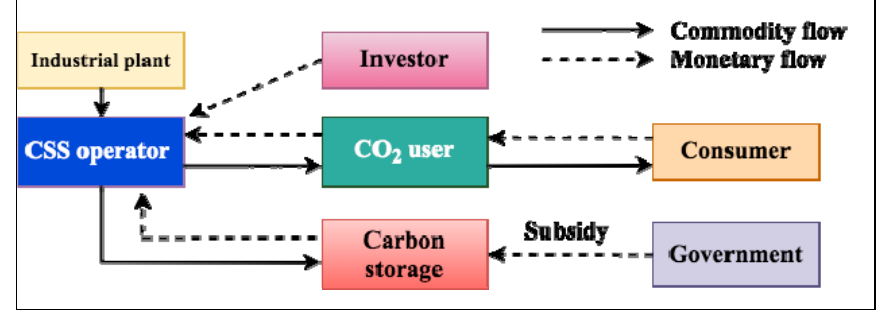
Figure 6. CCUS operator business model.